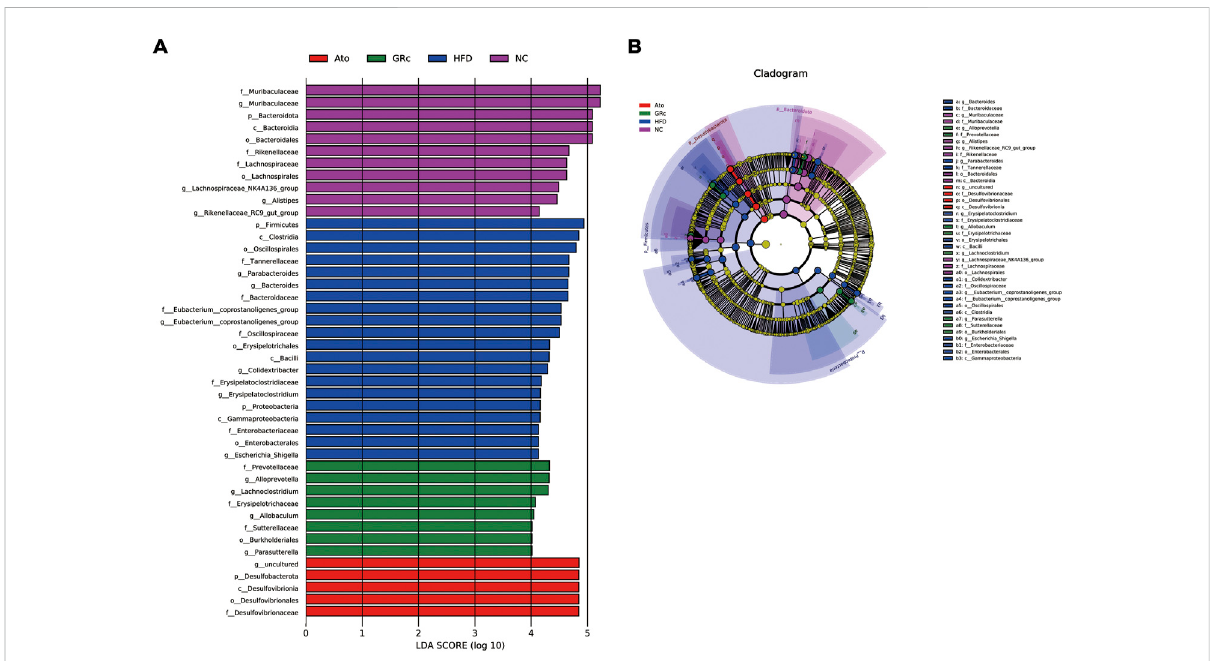
FIGURE 5 Core bacterial phenotype analysis in HFD-induced ApoE − / − mice ( n = 6). (A) LDA scores of taxa enriched at different taxonomy levels (LDA signi fi cant threshold = 4). (B) Taxonomic cladogram generated by LEfSe analysis showing taxa signi fi cantly enriched in the NC group (purple), HFD group (blue), GRc group (green), and Ato group (red), respectively. Each ring represents a taxonomic level from phylum to genus. The diameter of each dot on the ring represents the relative abundance of the taxon. NC, normal control; HFD, high-fat diet; Ato, atorvastatin; GRc, ginsenoside